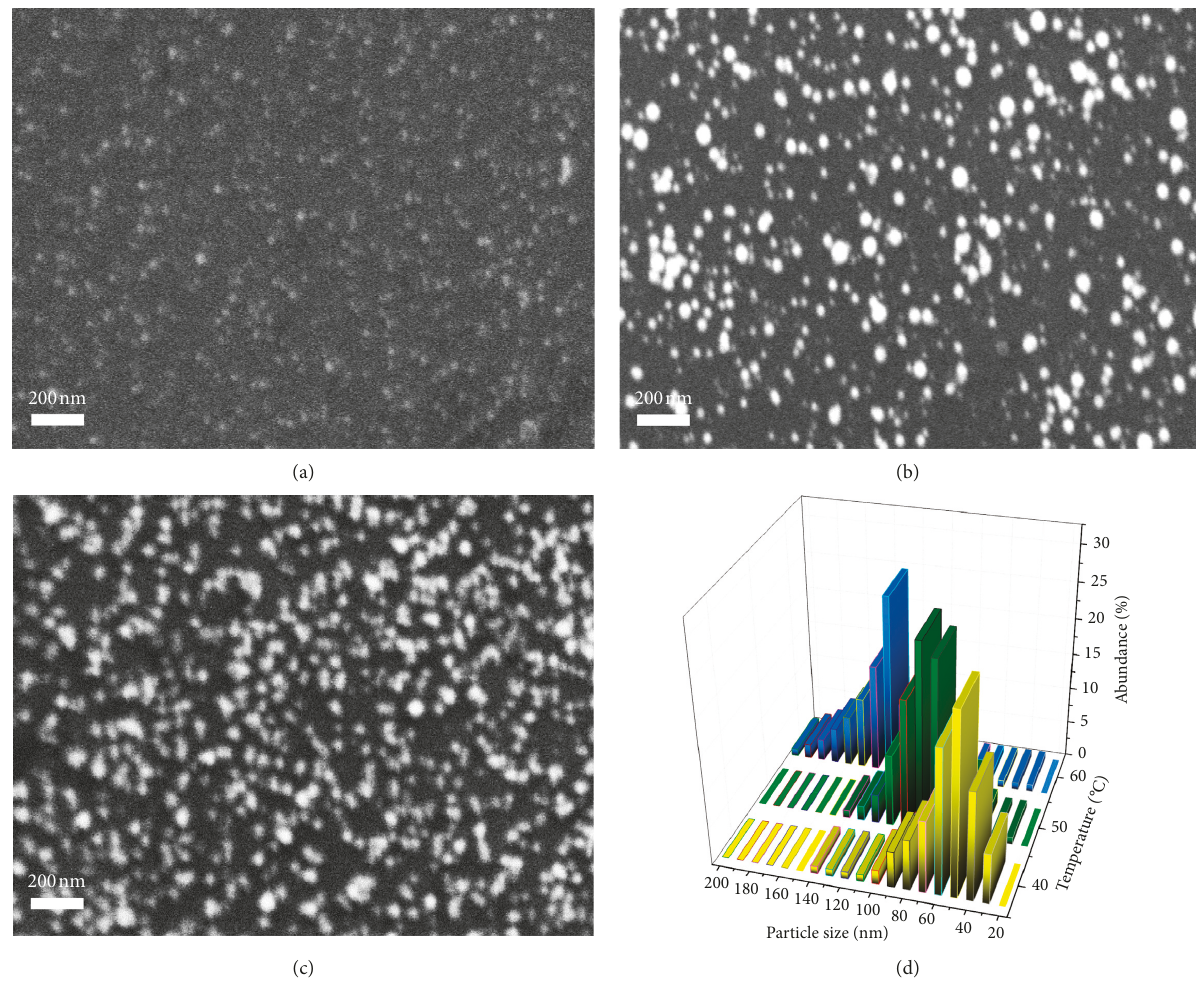
4 ] by the GR method in DMSO for 1min